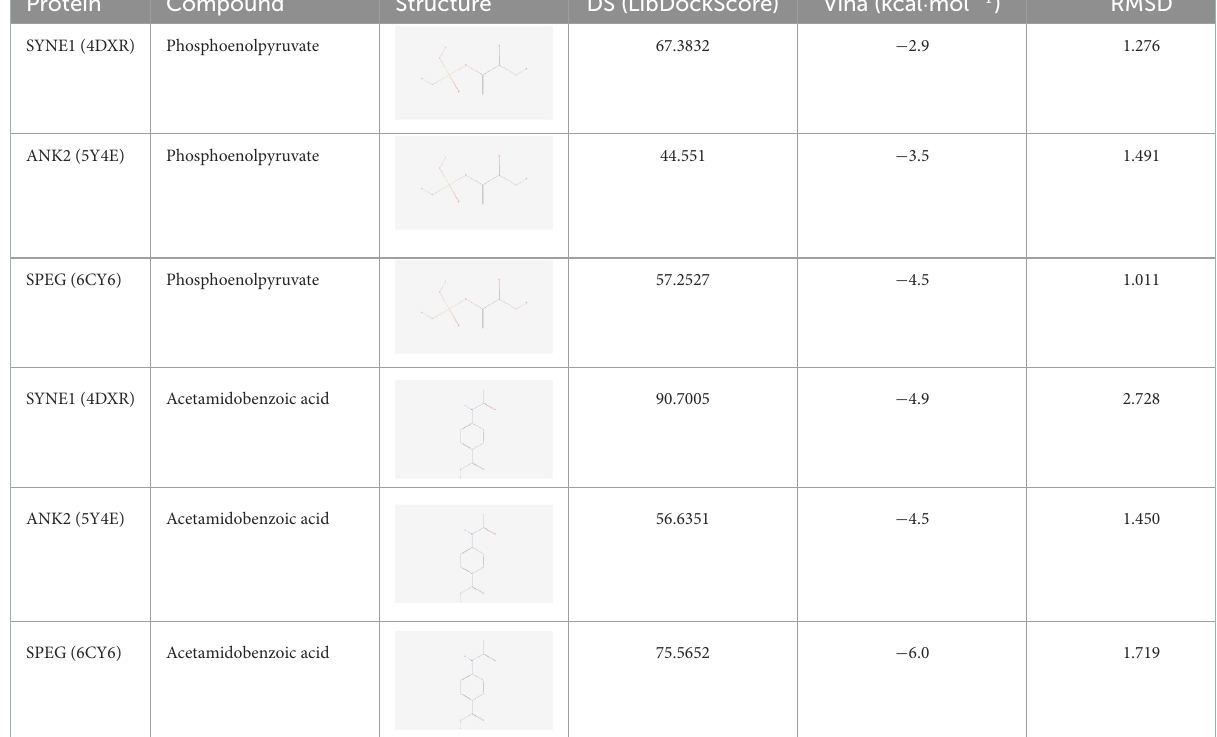
TABLE 1 Molecular docking and binding energy. Protein Compound